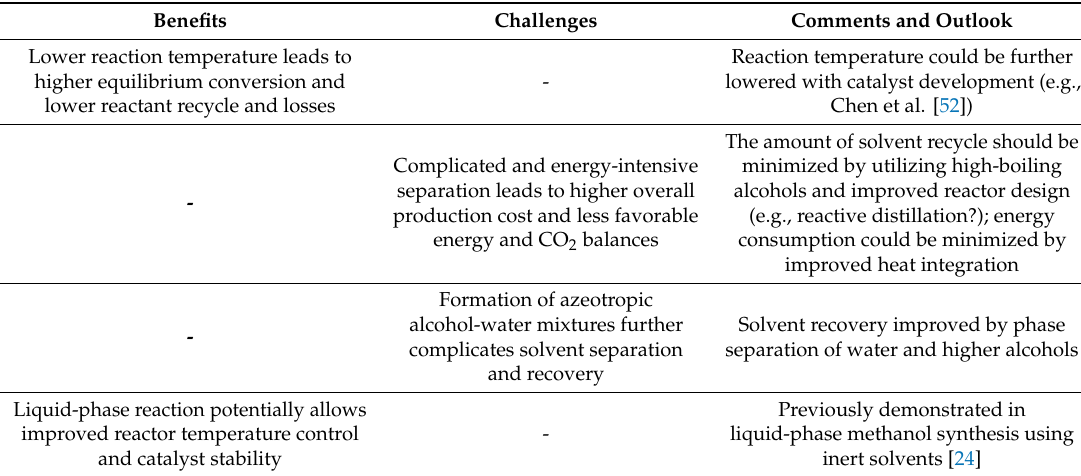
Table 8. Summary of the potential benefits and challenges of the liquid-phase CO 2 hydrogenation to methanol process with alcoholic solvents compared to the gas-phase process.